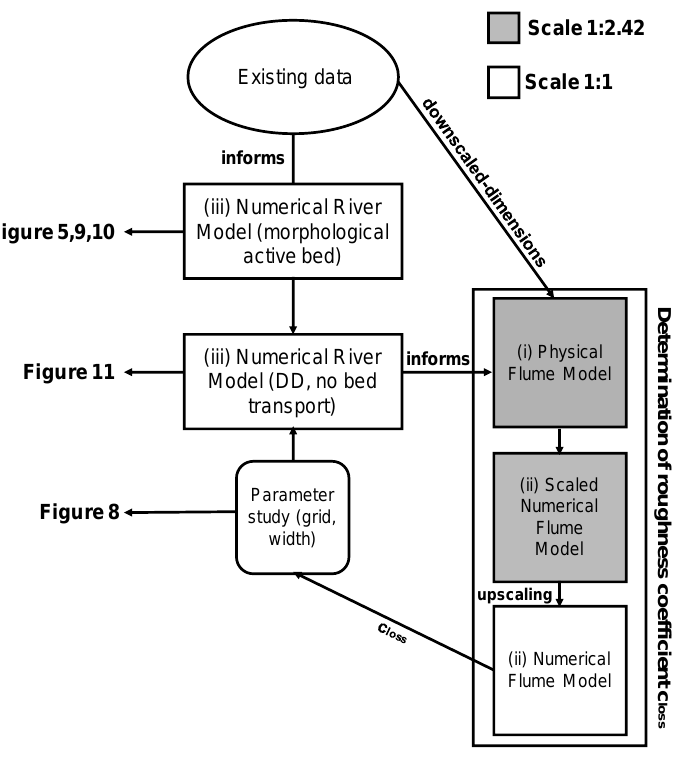
Figure 3. Flow chart of the Cross-scale multi-model approach including a domain decomposition (DD)-model developed and employed illustrating the interdependence of the modelling-packages. This way, different spatial discretizations are realised, allowing to increase the resolution within target areas, whilst reducing the grid resolution for areas not so crucial, thereby optimizing the computational